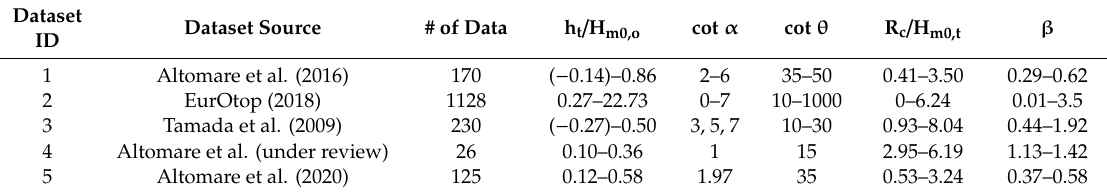
Table 1. Characteristics of extracted data for sea smooth sea dikes and vertical